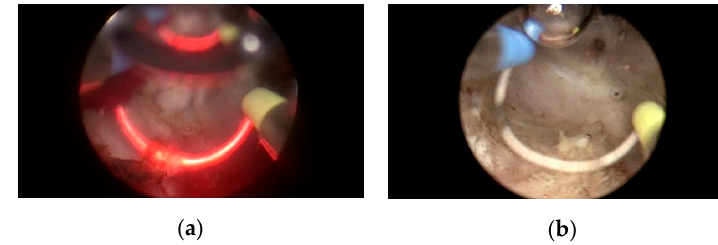
Figure 2. Two types of images: ( a ) the image with the red light and ( b ) that without the red light.